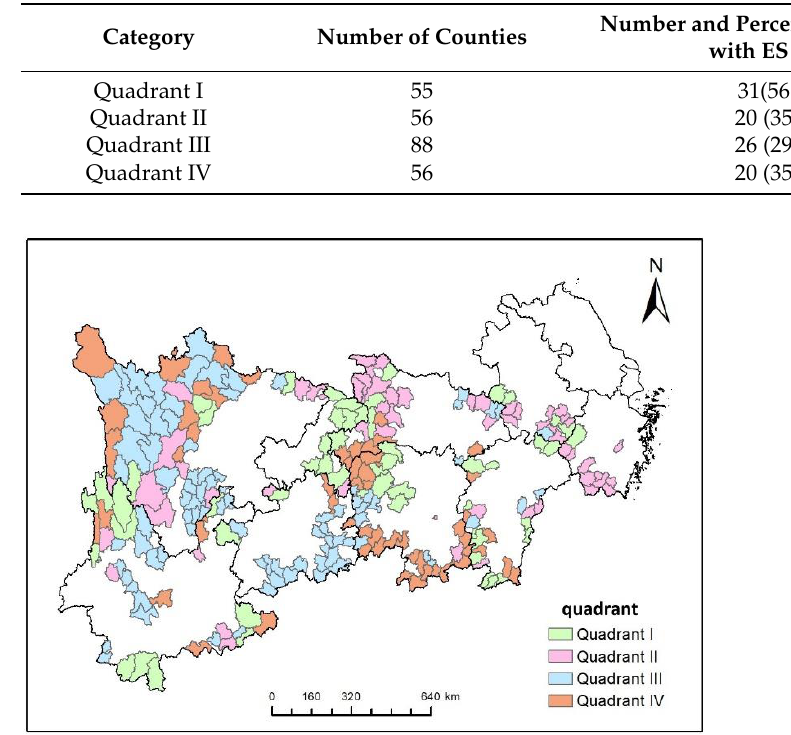
Figure 6. Mapping for categorization of National Key Ecological Function Counties in the Yangtze River Economic Belt.